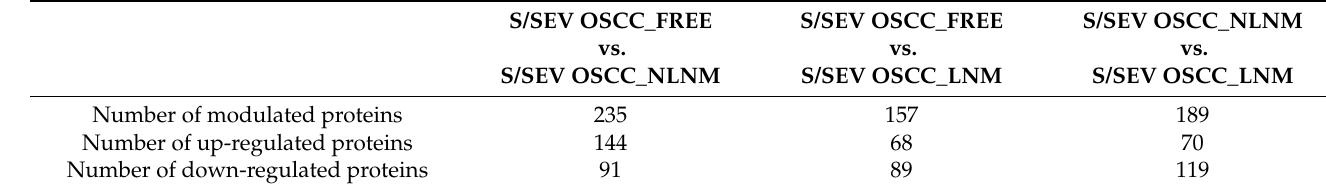
Table 4. Summary of proteome quantitative analysis. S/SEV OSCC_FREE vs.